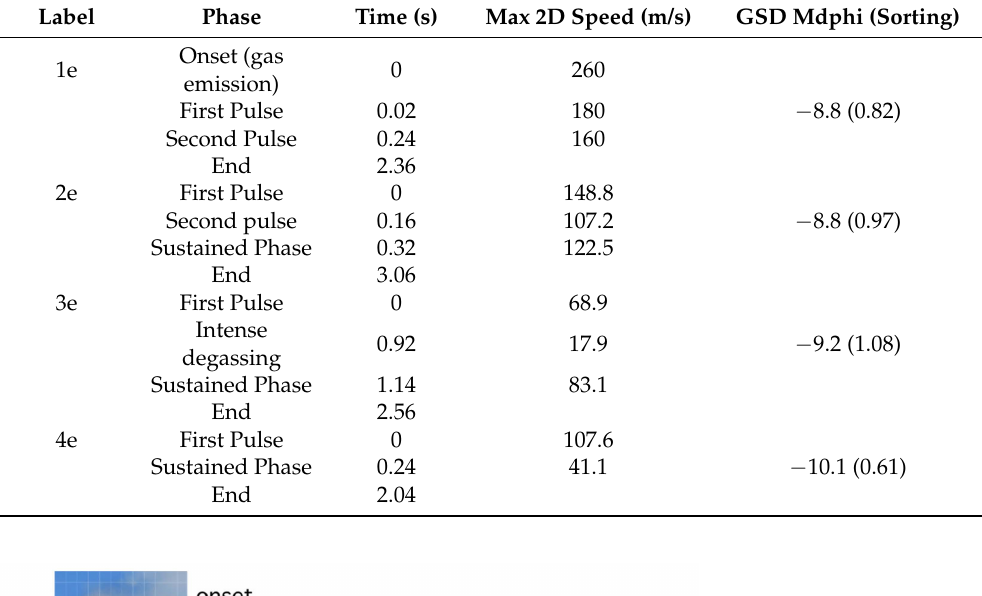
Table 4. Dynamics of the four major explosions of the studied sequence. The numbers in ‘Label’ indicate the corresponding video. GSD= Grain Size Distribution.